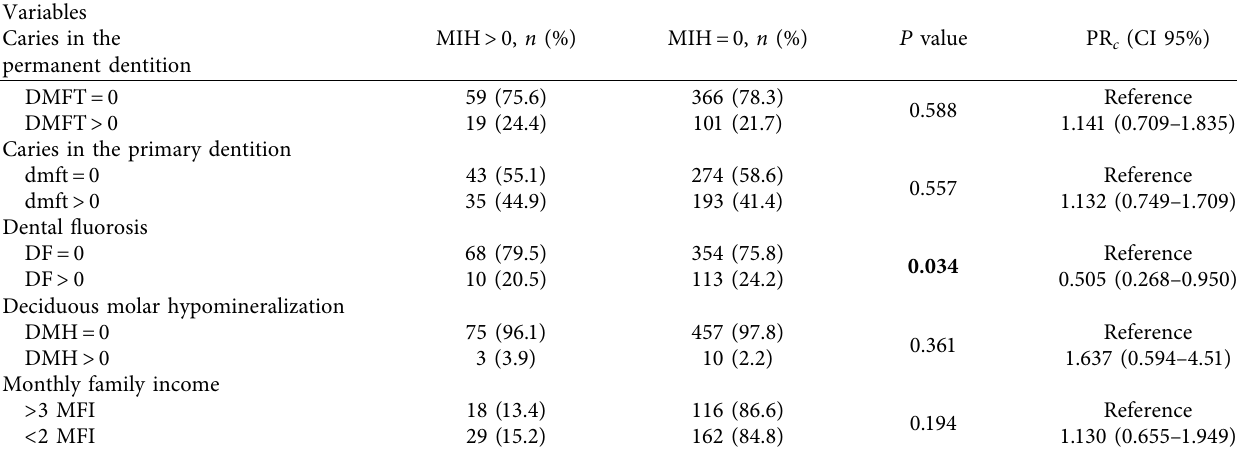
Table 5: Association between MIH and associated factors (clinical and socioeconomical). Variables